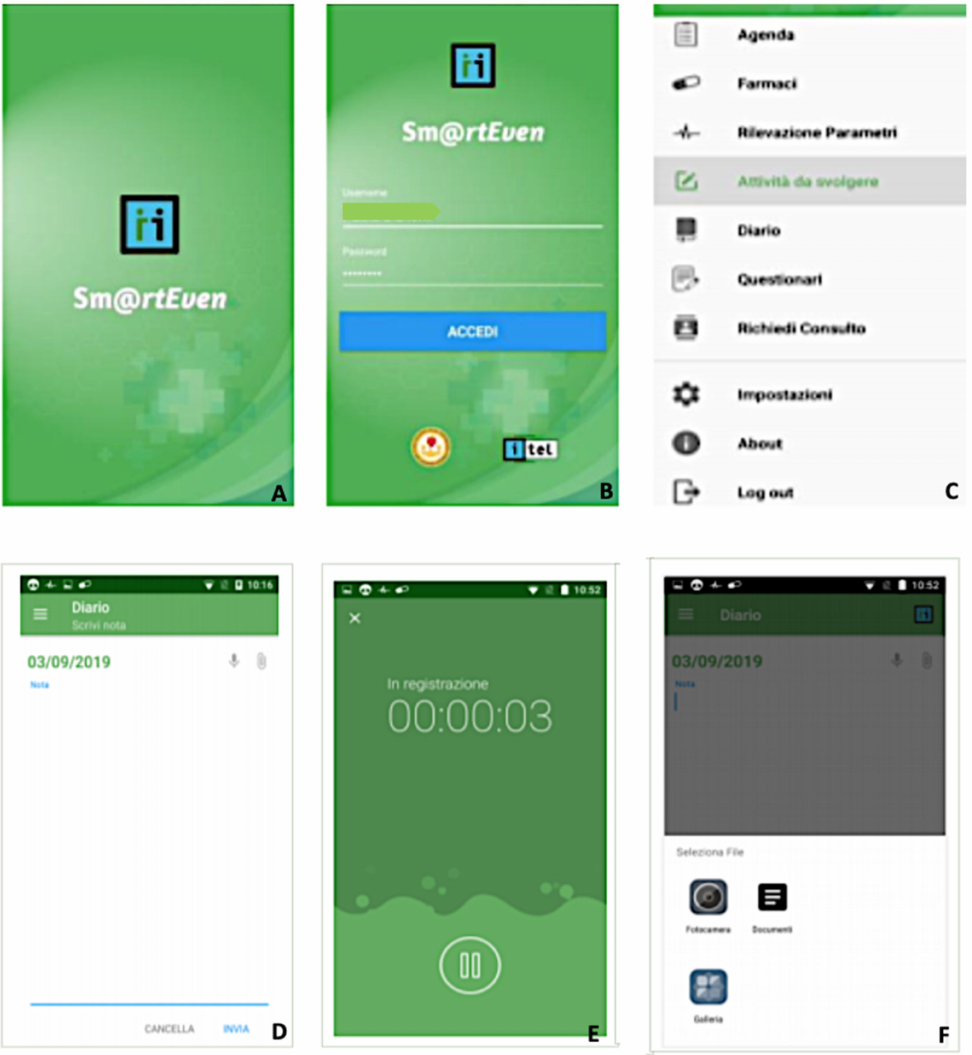
Figure 3. Sm@rtEven application: ( A ) initial web page; ( B ) screen for entering the patient’s per- sonal data; ( C ) main menu of the application, with the list of available functions; ( D – F ) secondary screens showing the possibility of inserting a note and attaching audio files, documents or images. The application also makes it possible to record a short voice message or attach a file from the smartphone’s